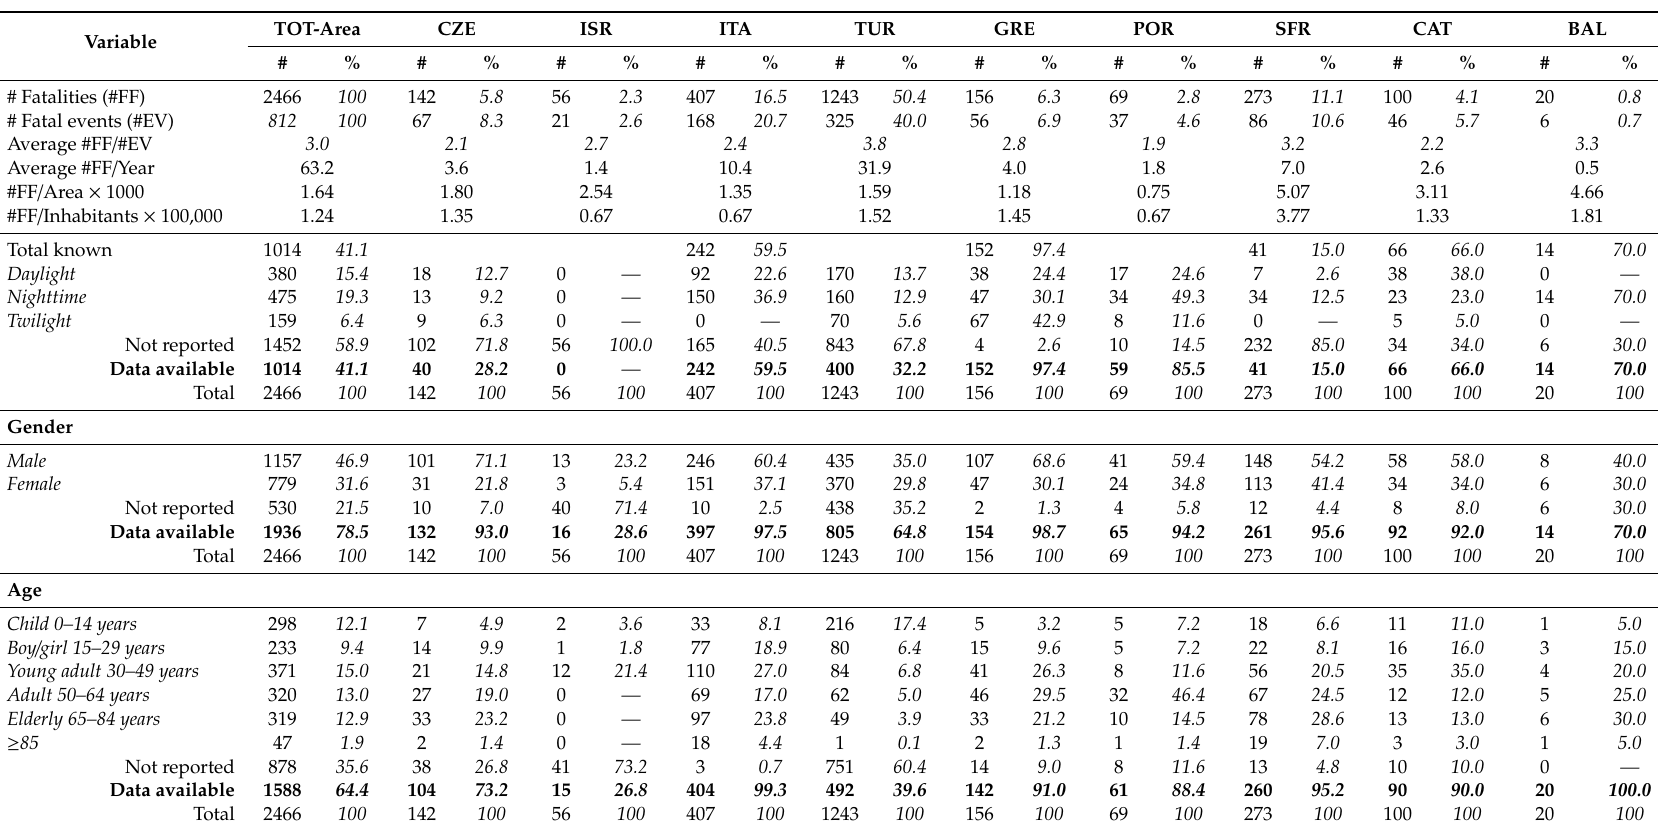
Table A1. EUFF Database: Summary of Data, Light Conditions, Gender, and Age of Fatalities per TOT-A, and per Each SA (the acronyms are the same as in Figure 1. #: Number; %: Percentage). Data available are in bold and percentage in